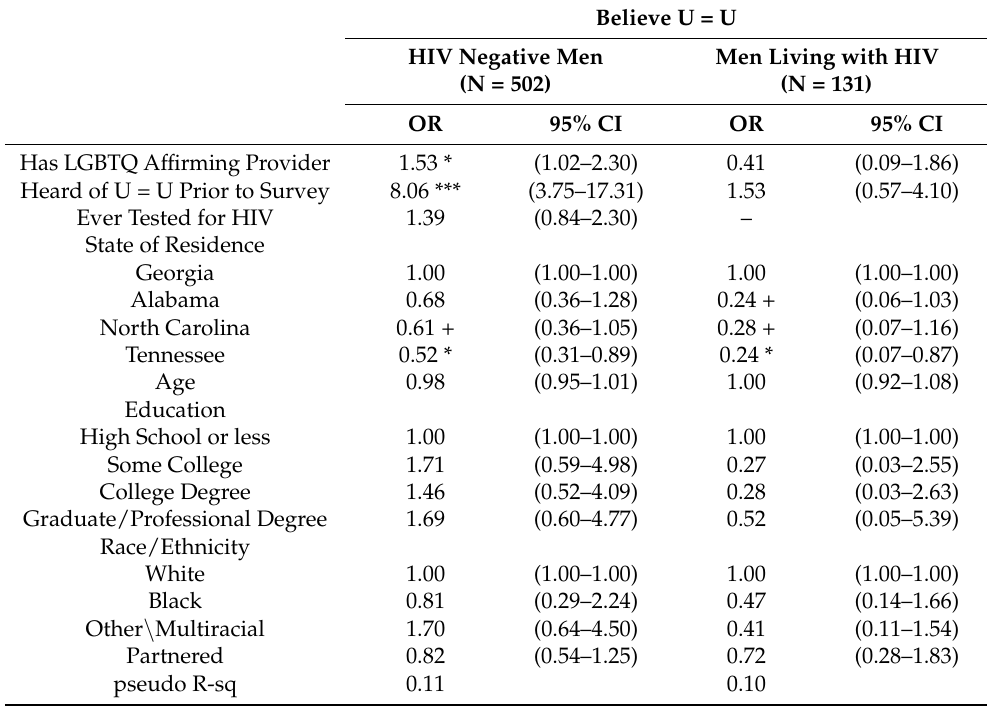
Table 6. Estimates of U = U belief among a sample of midlife and older gay and bisexual men in the US south by HIV status, VUSNAPS.